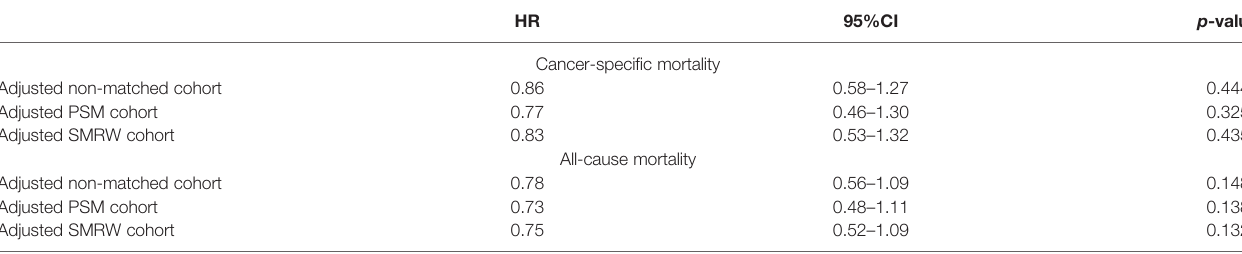
TABLE 2 | Effect of RT and RP on the survival